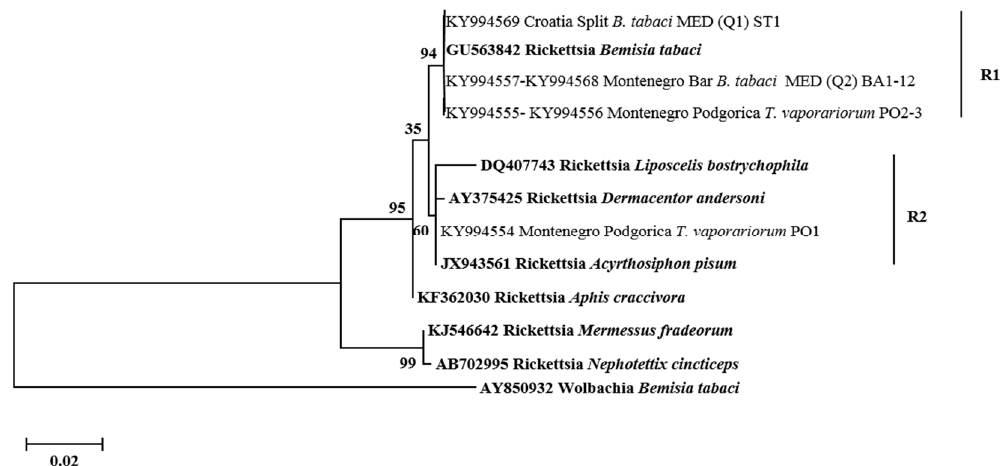
Figure 5. Molecular phylogenetic placements of Rickettsia from whitefly species. The tree was constructed via Bayesian inference (BI) using a GTR+G substitution model. Sequences from GenBank are indicated in bold, while those obtained in this study are rearranged based on geographical origin and associated whitefly hosts, B. tabaci and T. vaporariorum .